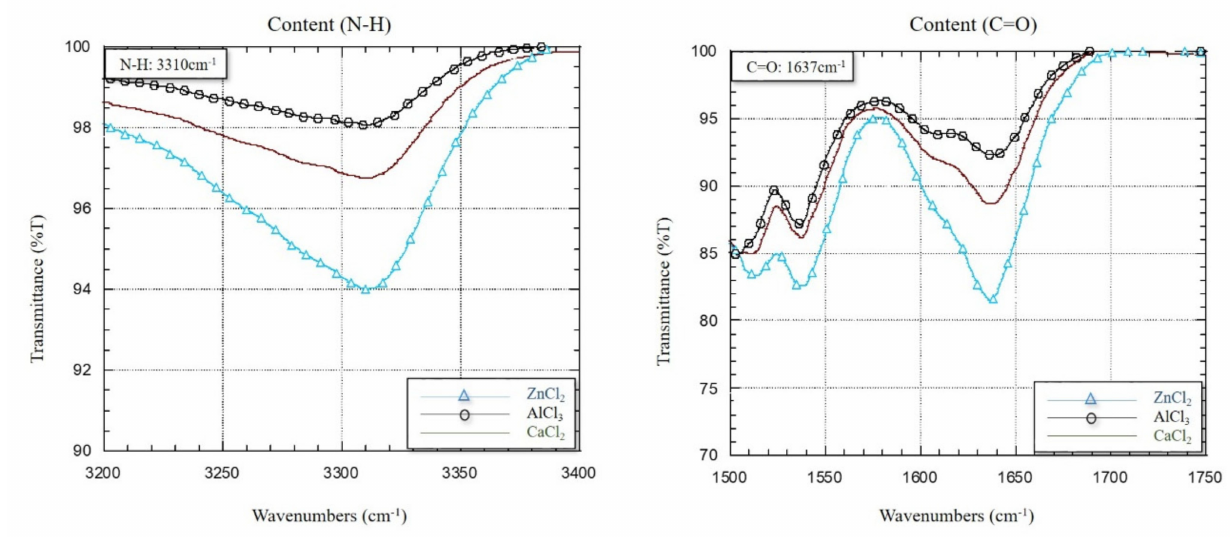
Figure 4. Treatment of aramid fibers with different Lewis acids by FT-IR